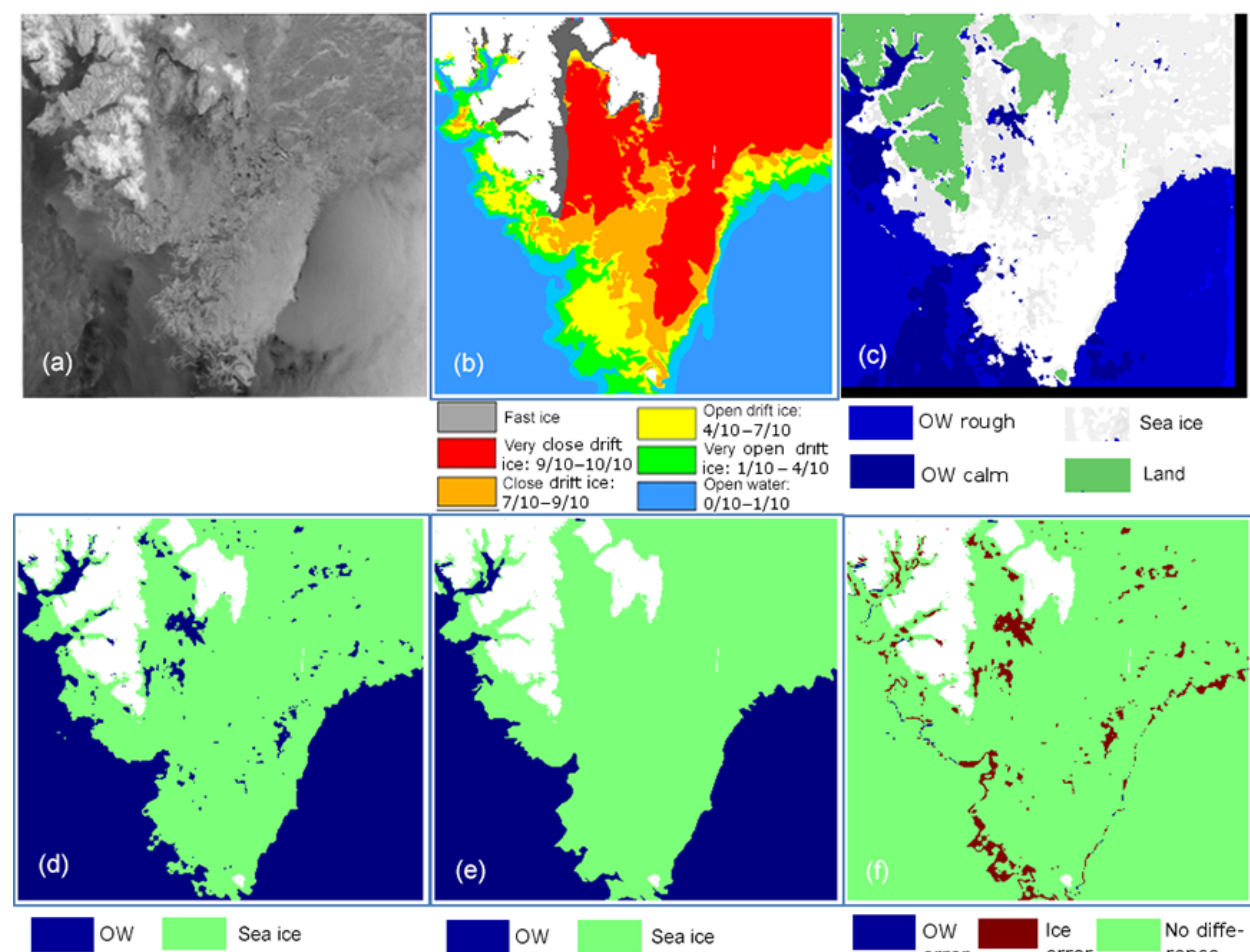
Figure 8. Validation procedure of automatic classification results compared to MET Norway ice charts. (a) Original RS2 SCW SAR image (HH polarization), taken over the southern part of Svalbard on 14 March 2013. (b) Collocated subset of manual ice concentration chart, provided by the Norwegian Ice Service (met.no) for the same day. (c) Result of the SVM classification. (d) Result of the SVM classification with delineation of two classes: water and sea ice. (e) Ice chart of MET Norway reclassified into two classes: open water (ice concentration from 0 to 10%) and sea ice (ice concentration from 10 to 100%). (f) The difference of recalculated MET Norway chart and classification result represents the error matrix as “image”: no difference, sea ice error (sea ice in MET Norway, OW in our results), and OW error (OW in MET Norway, sea ice in our results). Overall accuracy is 95.78%, OW error is 0.19%, and ice error is